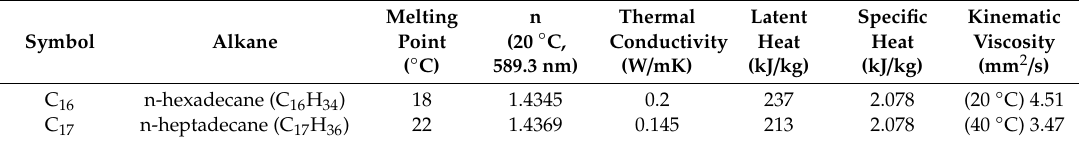
Table 1. Properties of the higher alkanes used